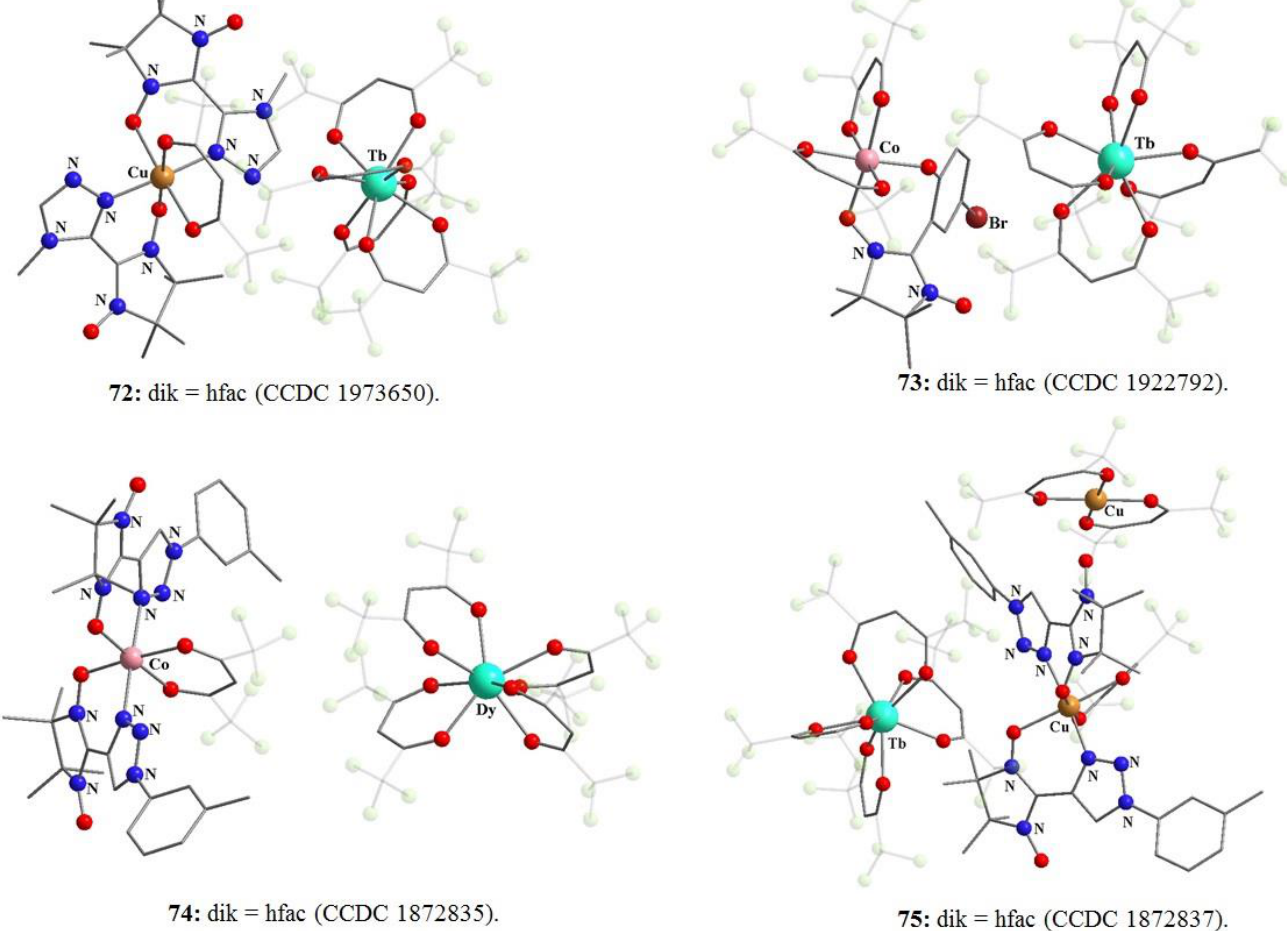
Figure 36. The examples of 3d/4f complexes containing Ln(III) tetrakis - β -diketonate fragments. CF 3 groups are transparent for clarity. The cif has been retrieved from CCDC. [110 – 112]